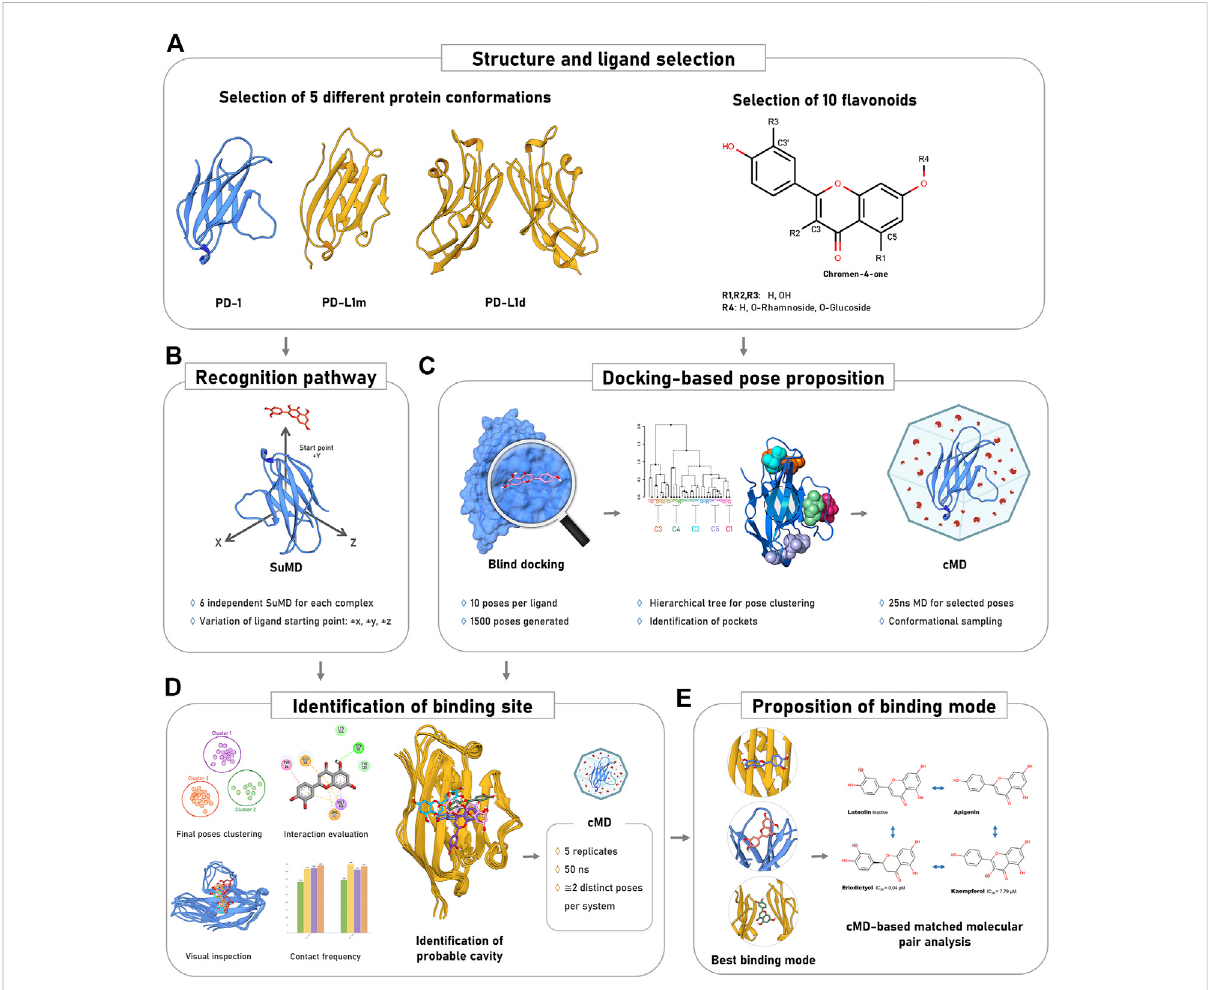
FIGURE 2 Overview of the methodological approach. (A) The inputs for simulations and docking encompassed different protein states and diverse fl avonoid structural constructs. R1 to R4 represent substitution positions in the fl avonoid scaffold. (B) Construction of 540 complexes to search for newfavorablecavitiesthroughunbiasedSupervisedMolecularDynamics. (C) Predictionandsimulationof fl avonoidbindingmodespriortocomplex stability evaluation. (D) Proposition of the best interaction cavities on the PD-1 and PD-L1. (E) Correlation between the fl avonoid-protein interaction and experimental